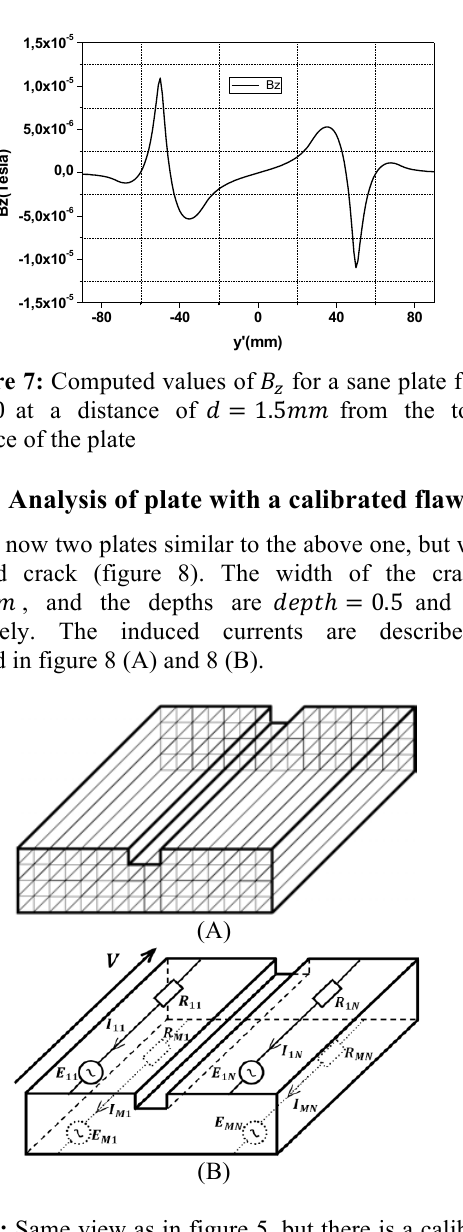
field) at a distance !